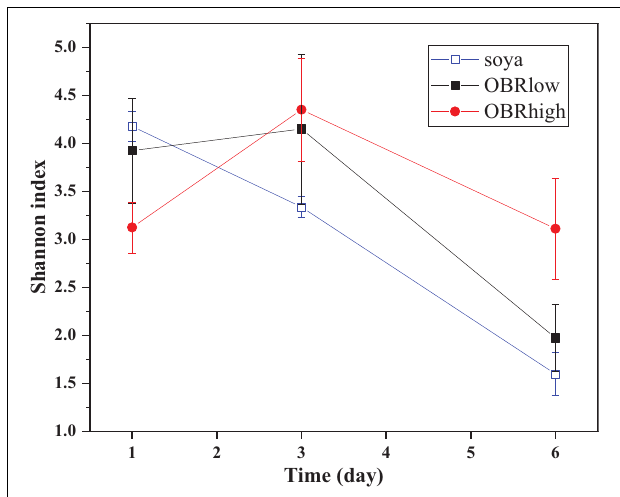
FIGURE 3 | The community diversity (mean ± SE) of gut bacteria. The soya, OBRlow, and OBRhigh treatments contained only soybean meal, low amounts of OBR, and high amounts of OBR, respectively, 1, 3, and 6 represent the first, third, and sixth day, respectively.